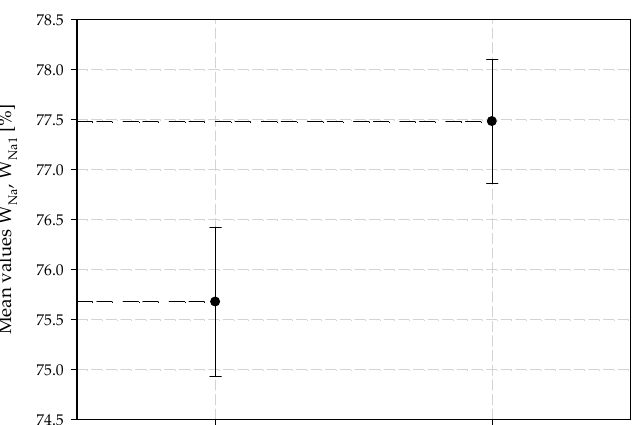
Figure 7. Mean W Na and W Na1 values with and without dosing AAB to B10. Direct alkalinity with and without dosing of AAB to B10